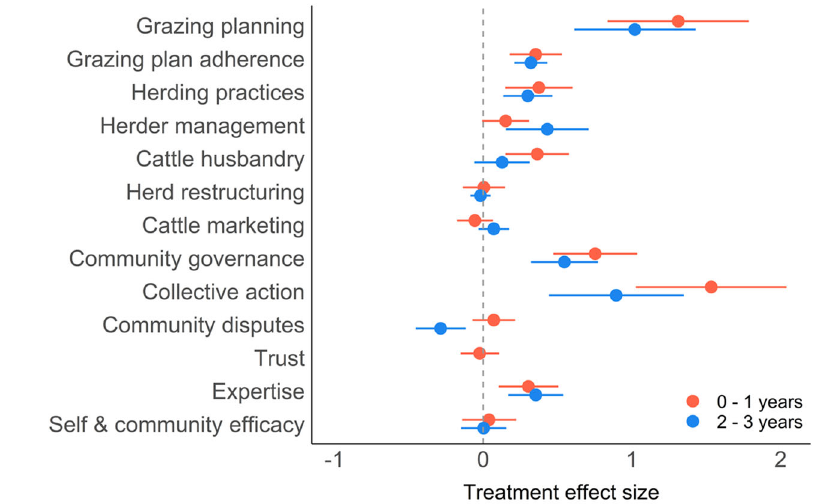
Fig. 2 Effect of community-based rangeland management (CBRLM) on 13 indices of social and behavioral outcomes. Orange markers denote results 0 – 1 years after program end (2014) and blue markers denote results 2 – 3 years after program end (2016). For each index the mid-point is the standardized treatment effect size, with a corresponding 95% con fi dence interval. Supporting statistical results are shown in Table